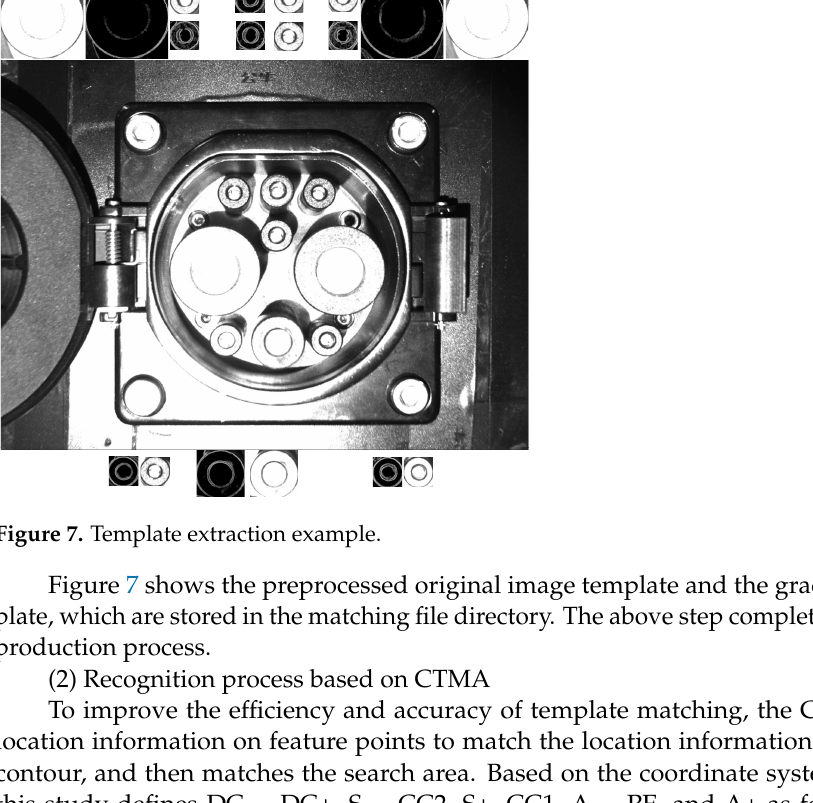
Figure 6. The flowchart of the automatic exposure algorithm.